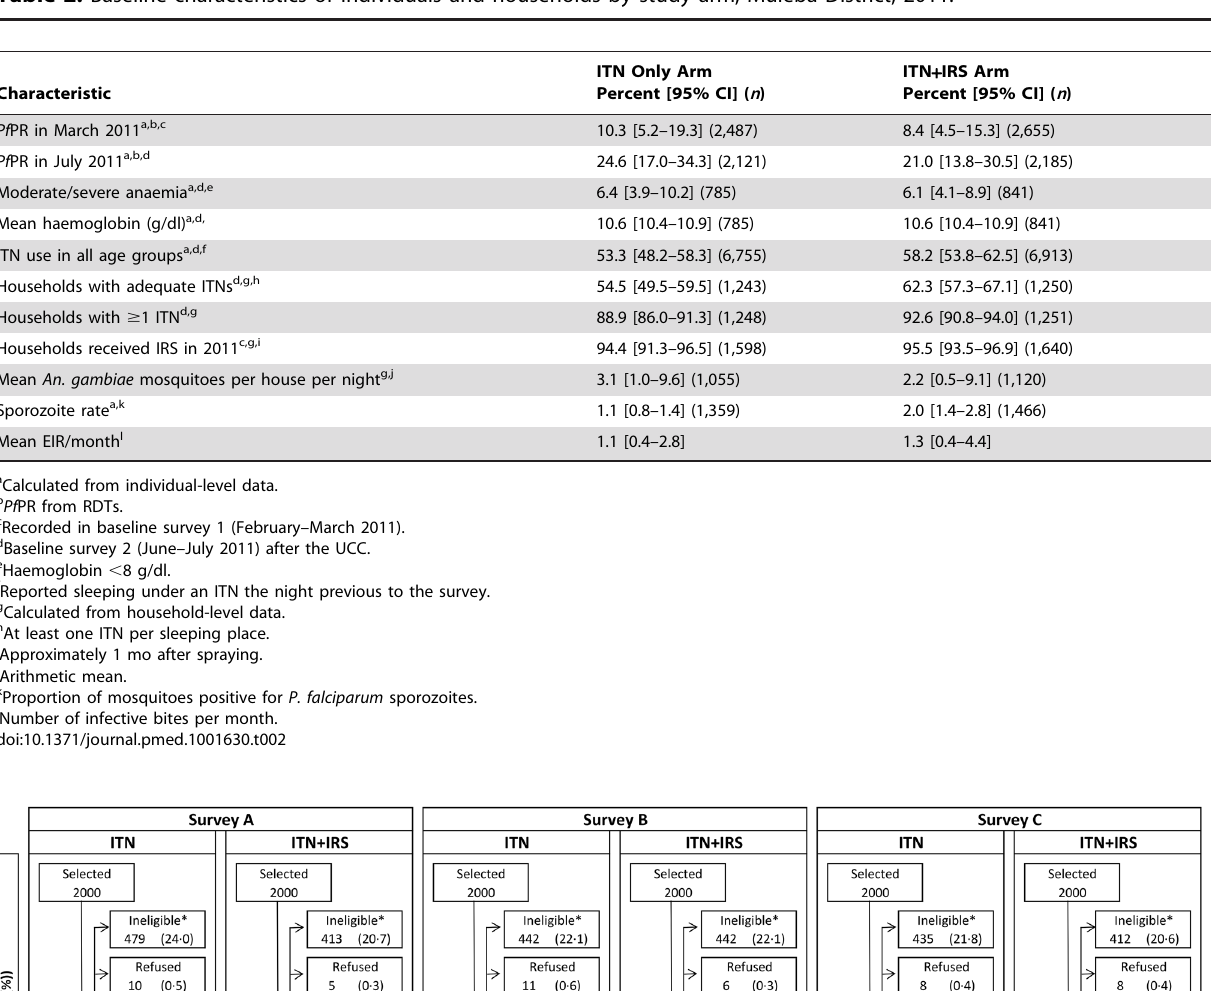
Table 2. Baseline characteristics of individuals and households by study arm, Muleba District, 2011.